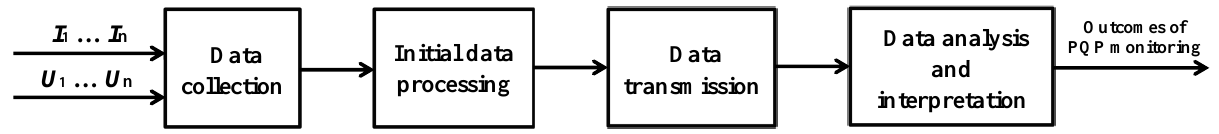
Figure 2. The process of monitoring power quality parameters in the EPDN.